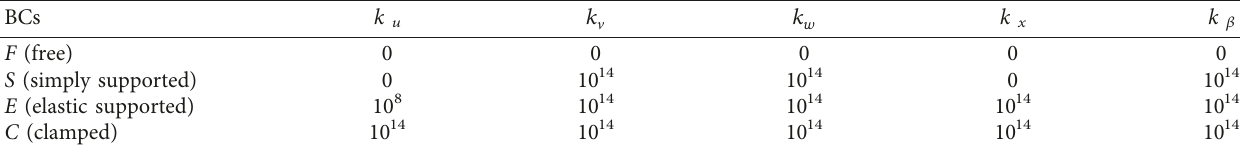
Figure 3: Variation of frequency parameters with various stiffness values of boundary springs: (a) axial bulkhead and (b) circumferential bulkhead. Table 1: Stiffness value of boundary spring is according to the boundary